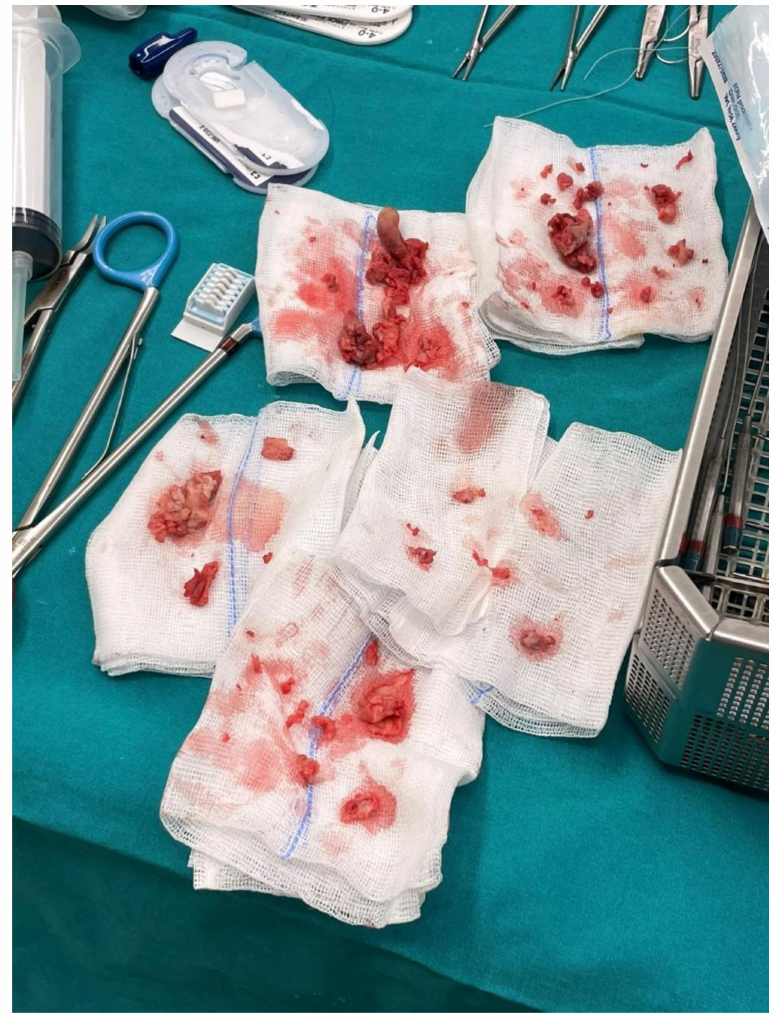
Figure 10. Anatomopathological specimens extracted from both mitral and tricuspid valves represent multiple vegetations of different